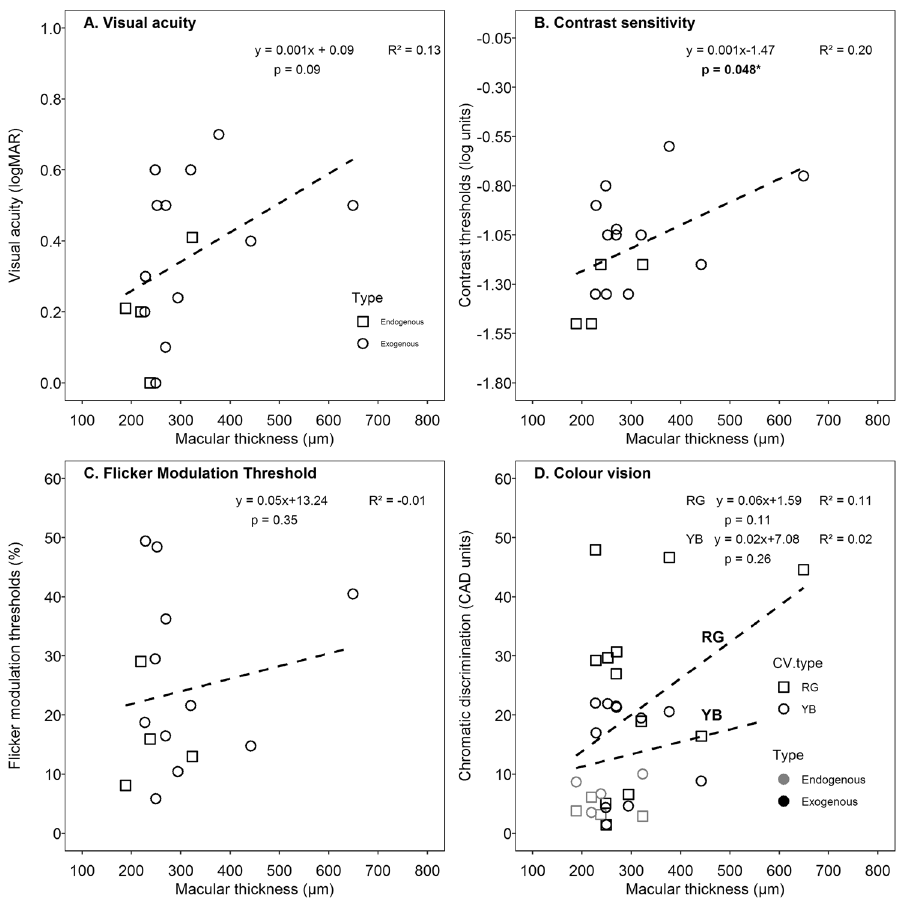
Figure 4. Scatterplots of visual functions against the foveal thickness. ( A , B ) shows visual acuity, and log contrast thresholds plotted against central macular thickness. ( C ) Show flicker modulation thresholds plotted as a function of central macular thickness. Different shape symbol in the panels ( A – C ) indicate the exogenous (open circles) and endogenous (open squares) types of endophthalmitis. ( D ) Show R-G and B-Y chromatic thresholds plotted against macular thickness. The different shape symbols in the panel indicate RG and RB colour vision. The black and grey symbols refers to exogenous and endogenous endophthalmitis respectively. The dashed lines show the regression line fitted by a linear function whose equation is provided in each of the